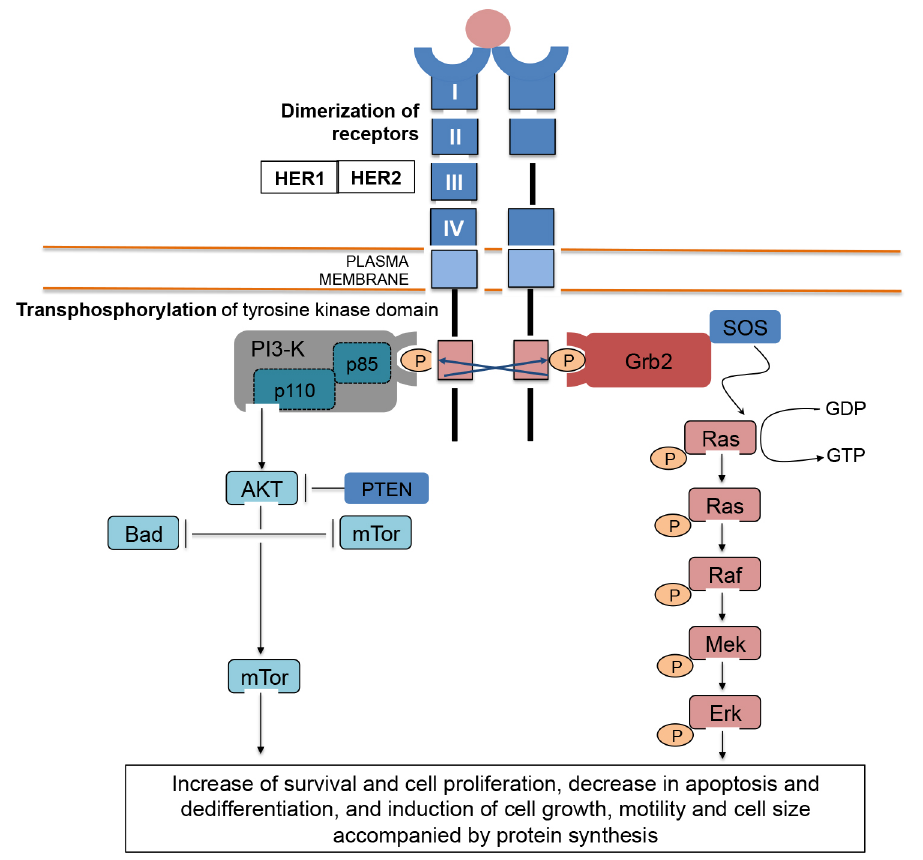
FIGURE 2 - Activation of the cytoplasmic signaling pathways Ras/Raf/MEK/Erk1-2 and phosphatidylinositol 3-kinase (PI3-K/ AKT) following dimerization of human epidermal receptors (e.g., HER1/HER2 heterodimer) resulting from recognition of the receptor extracellular domain by